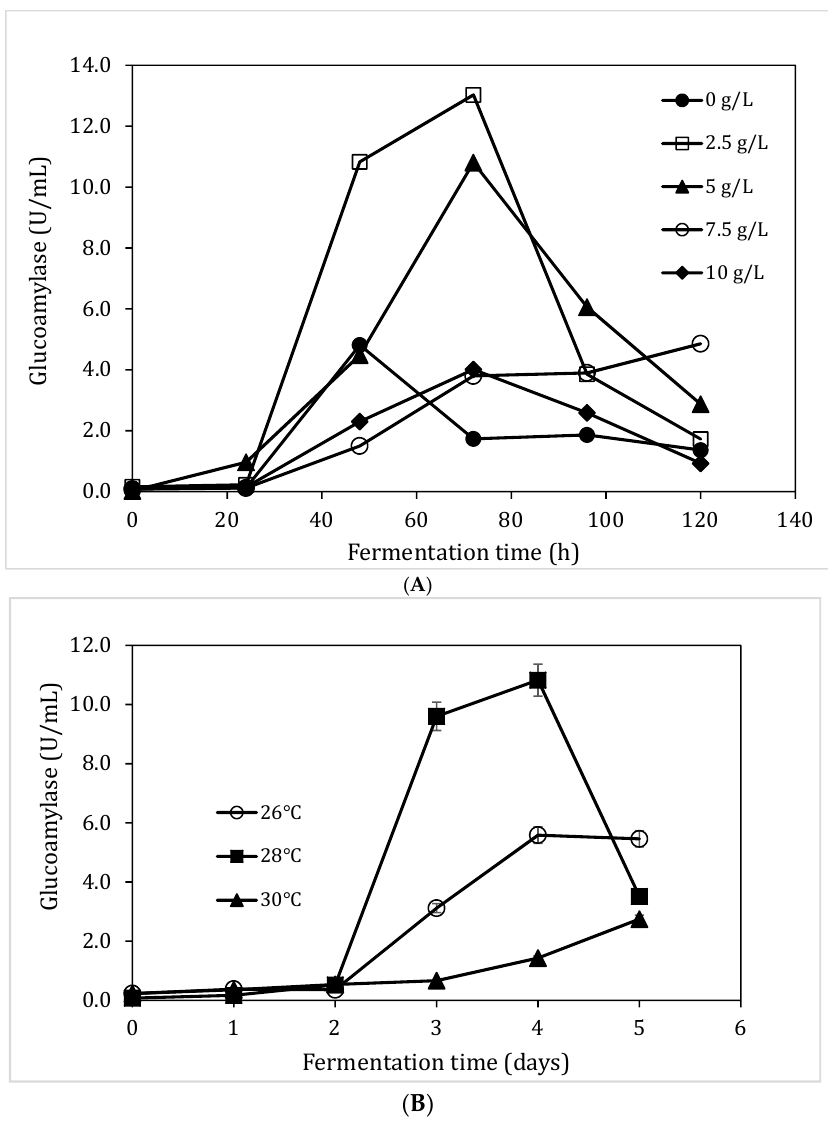
Figure 5. The effect of yeast extract ( A ) and temperature ( B ) on glucoamylase production in SmF. Fermentation was using 10% (w/v) sorghum bran, with mineral solution C at pH 6.0.